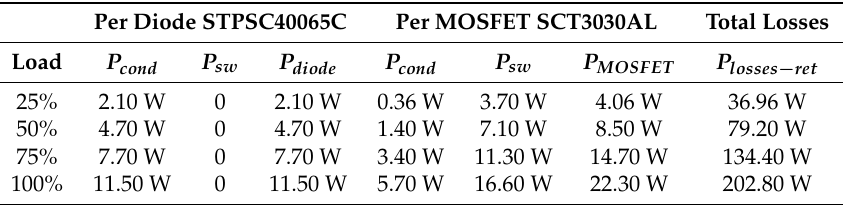
Table 2. Losses calculated for the rectifier operating at 102 kHz switching frequency.